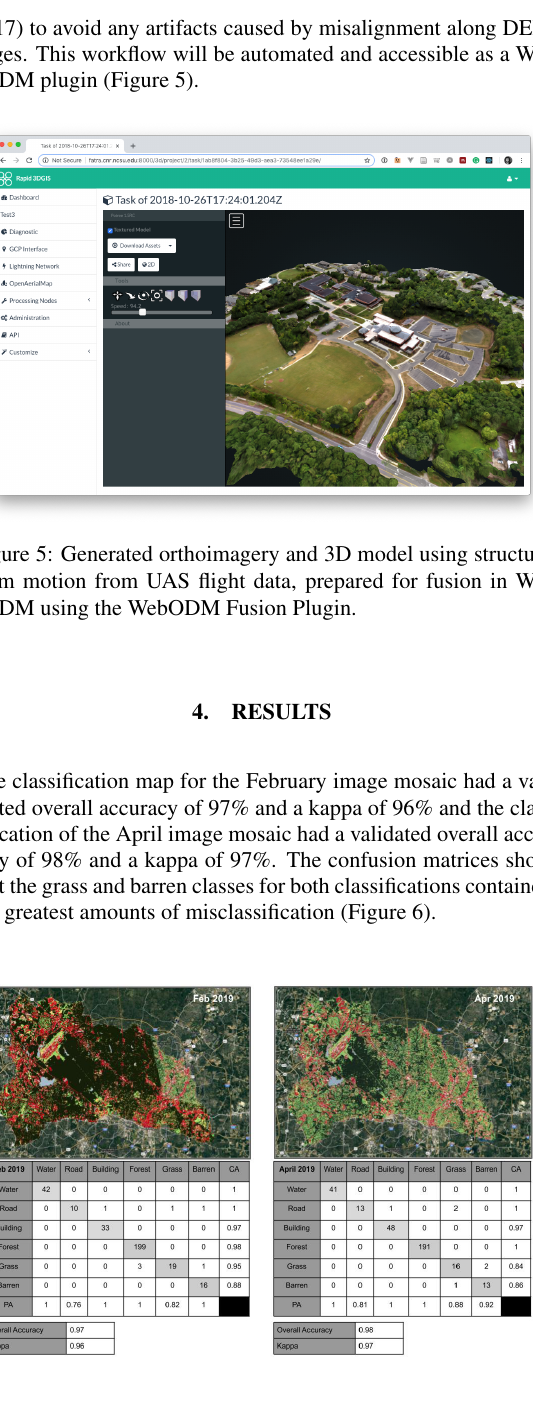
Figure 6: Validated accuracy assessments of random forest clas- sification for February 2019 (left) and April 2019 (right) image